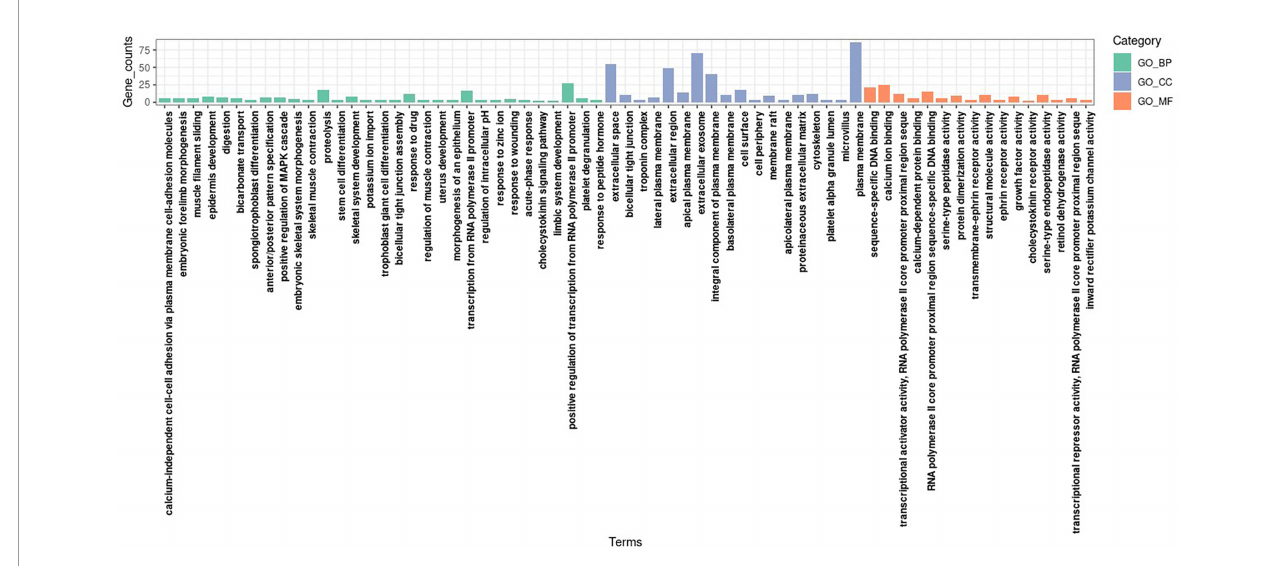
FIGURE 3 | GO enrichment analysis results of DEGs.